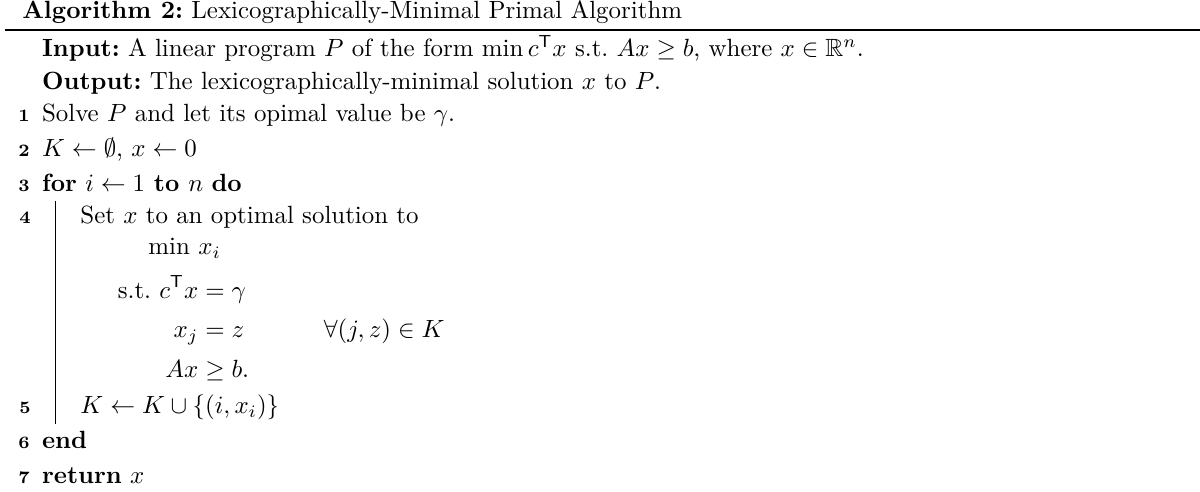
Algorithm 2: Lexicographically-Minimal Primal